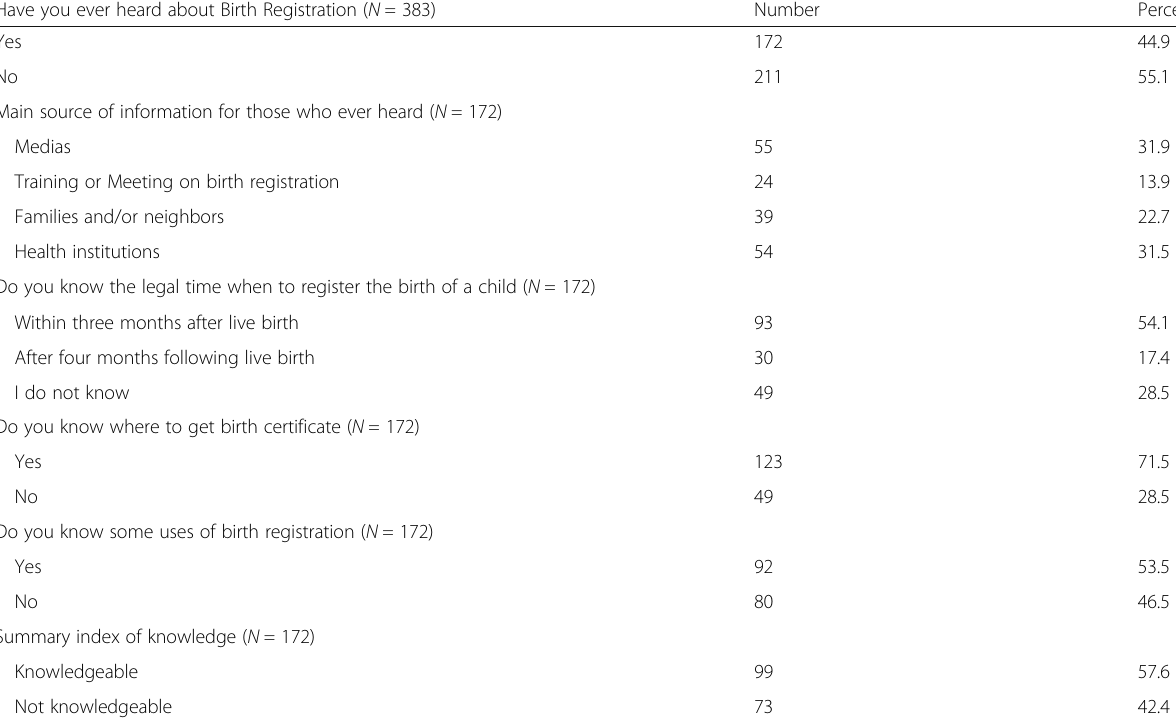
Table 3 Responses of the participants to the knowledge related information on birth registration and certification of a child, Tigray Region, Ethiopia, May,